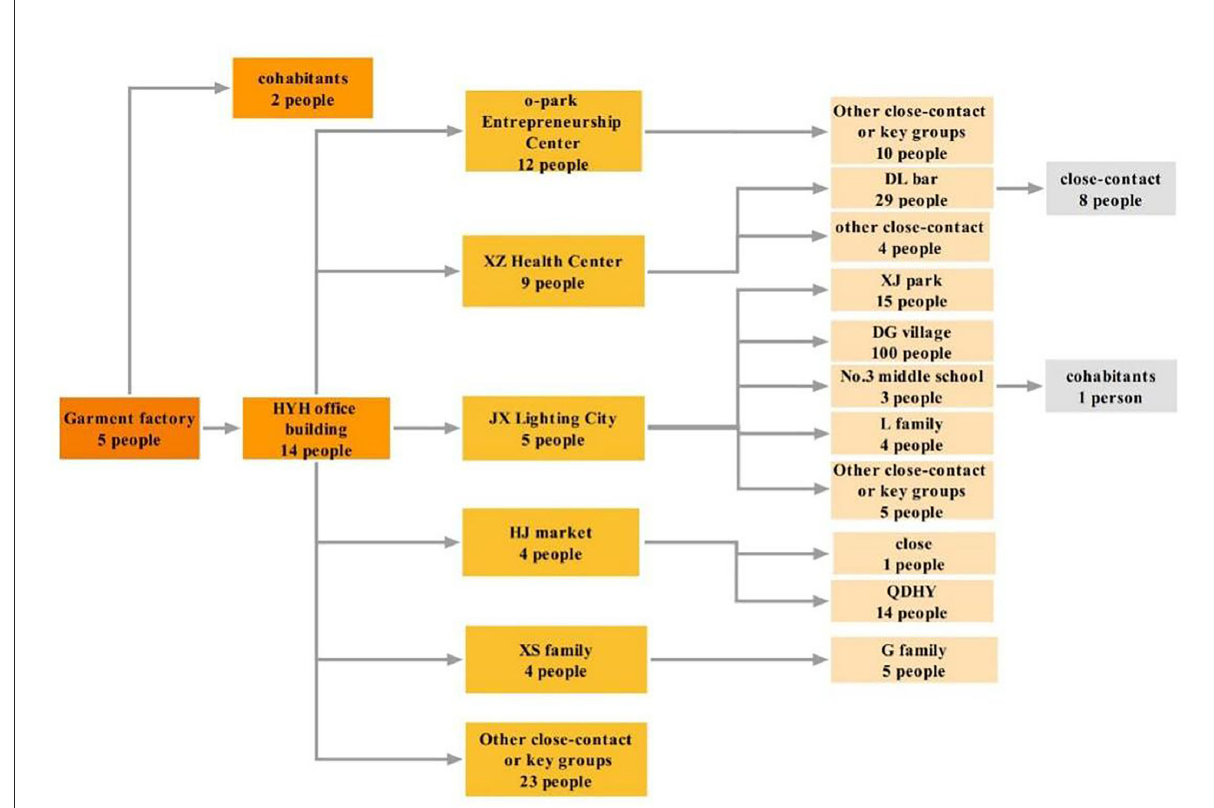
FIGURE3 Transmission profile of Omicron epidemic in Guangzhou. Numbers in the figure are based on the results of epidemiology investigation and gene sequencing; the transmission chain was identified with each key place as a single unit, and the different colors represented different